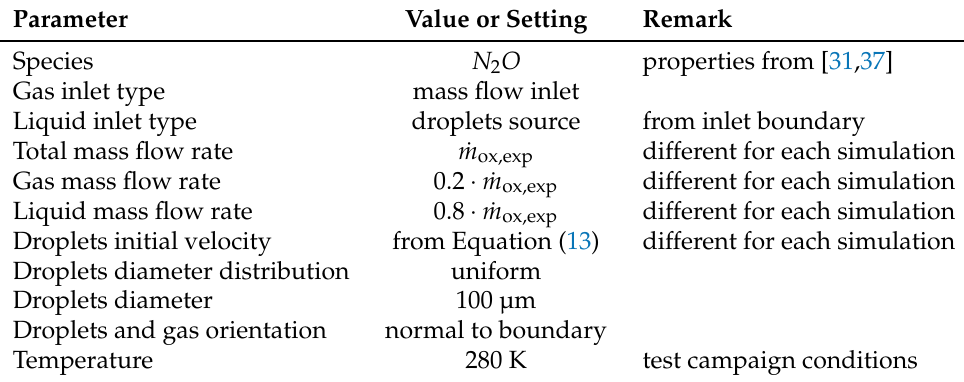
Table 2. Summary of oxidizer inlet boundary conditions for the baseline